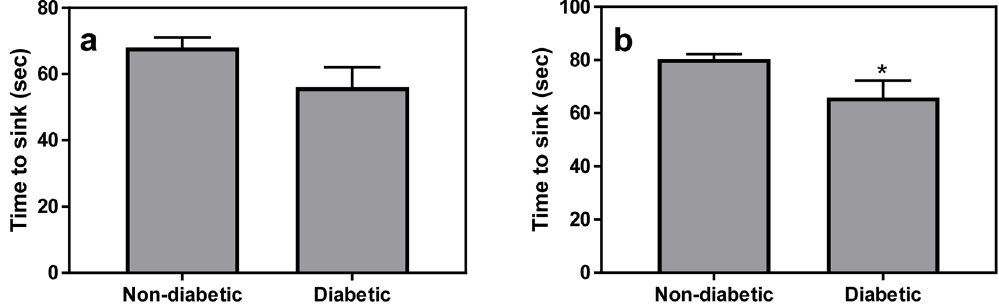
Figure 1. In the modified FST, diabetic fat sand rats exhibited a trend for lower time to Sink 1 ( a ) and a significantly lower time to sink 2 ( b ) compared with the non-diabetic animals. * Signifies p < 0.05 between the groups. N = 12 for non-diabetic group and 13 for diabetic